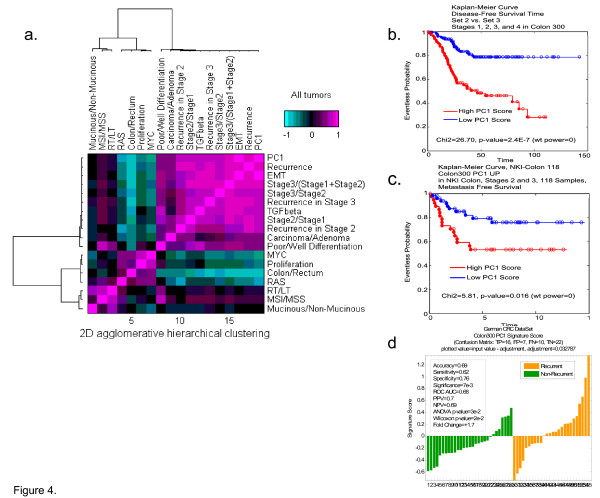
Covariance matrix showing correlation of PC1 with disease recurrence. (a) PC1, despite being developed with unsupervised approaches, appeared to correlate well with EMT, disease recurrence, disease progression, and differentiation status, but not with gene signatures linked to adenoma vs. carcinoma, MSI status, or mucinous vs. nonmucinous cancers. Moreover, PC1 appeared to be anti-correlated with RAS, MYC, Proliferation, and colon laterality. PC1 distinguishes good and poor prognosis patients in the MCC data set (b) as well as in two independent test sets: (c) Netherlands Cancer Institute (NKI, #13) (L.V.V.) and (d) Lin et al data sets [21].